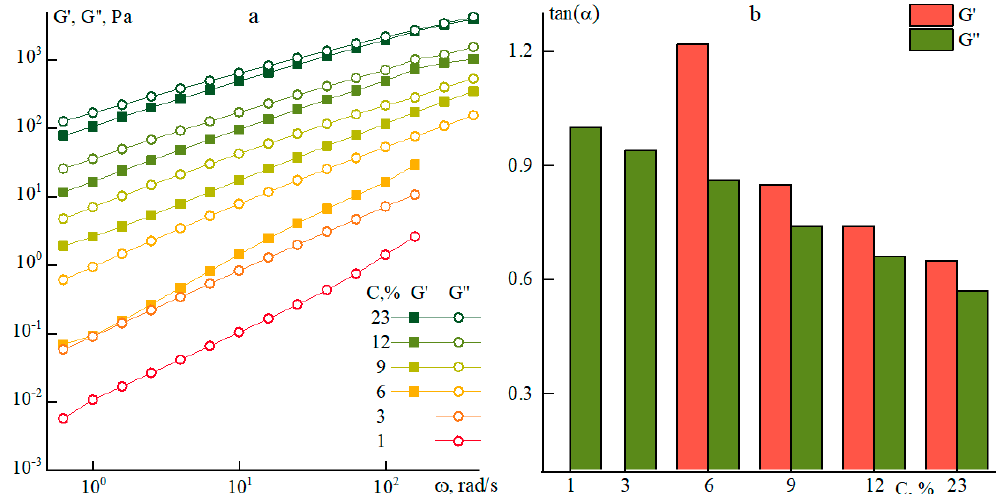
Figure 5. ( a ) Frequency dependences of elasticity and loss moduli and ( b ) a slope of the corresponding frequency dependences of moduli on solution P1 concentration at 25 ◦